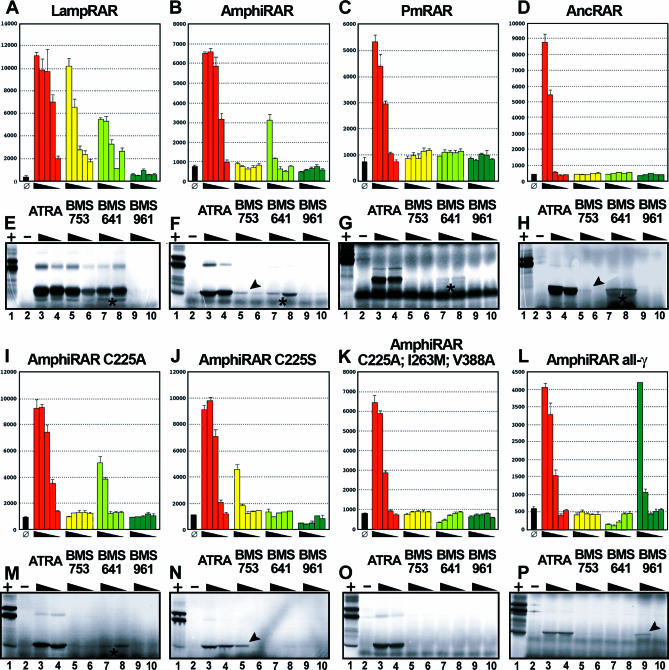
Transcriptional Activity and Binding Selectivity of Chordate RARsTranscriptional activity is shown in (A–D) and (I–L), and corresponding binding selectivity in (E–H) and (M–P). Identities of the chordate RARs for each activity-selectivity pair are indicated above each bar graph. Transcriptional activity is shown in (A–D) for LampRAR, AmphiRAR, PmRAR, and AncRAR, and that of AmphiRAR mutants is shown in (I–L). Partial proteolysis maps of the different in vitro-translated RARs are shown in (E–H) and (M–P). Chimeric GAL-RAR(LBD) transactivation methods, colour code of the transactivation figures, and contents of each proteolysis gel are as in Figure 3. Protected bands in the presence of BMS641 are indicated by an asterisk, and slightly protected bands are indicated by arrowheads.